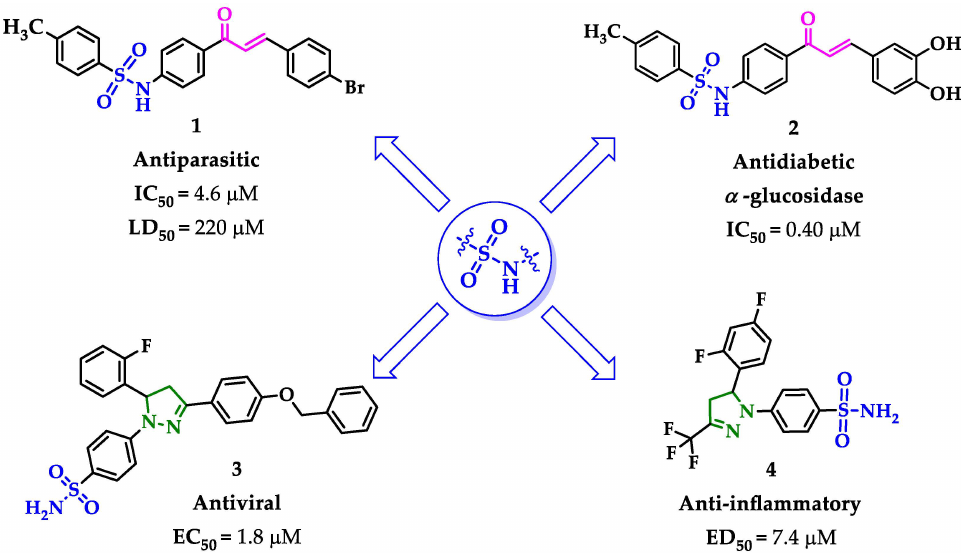
Figure 1. Sulfonamide moiety as promising candidate for molecular